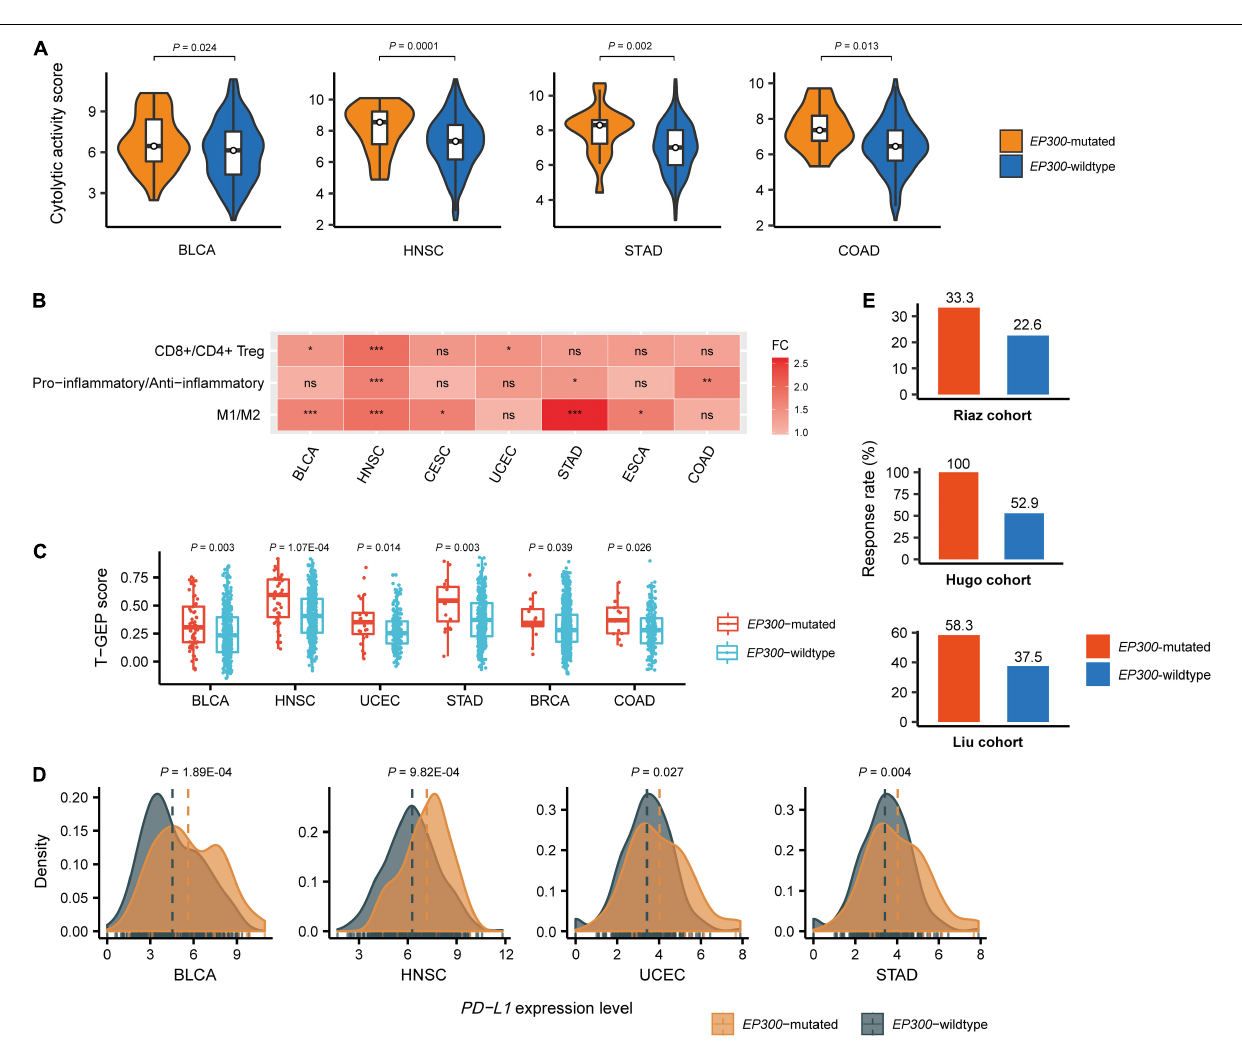
FIGURE 2 | Associations between E1A binding protein p300 ( EP300 ) mutations and antitumor immune signatures and immunotherapeutic response in cancer. Comparisons of immune cytolytic activity (CYT) scores (A) , the ratios of immune-stimulatory to immune-inhibitory signatures (CD8+/CD4+ regulatory T cells, pro-/anti-inflammatory cytokines, and M1/M2 macrophages) (B) , T cell-inflamed gene expression profile (T-GEP) scores (C) , programmed death-ligand 1 ( PD-L1 ) expression levels, and the response rates to immune checkpoint inhibitors (ICIs) (E) in EP300 -mutated and EP300 -wild-type cancers. The CYT score is the average expression level of two marker genes ( GZMA and PRF1 ) in the tumor (Narayanan et al., 2018). The ratio of immune-stimulatory to immune-inhibitory signatures is the log2-transformed geometric mean expression levels of the marker genes of immune-stimulatory signatures over those of immune-inhibitory signatures. The T-GEP score is the ssGSEA score of 18 T cell-inflamed genes (Ayers et al., 2017). The response rates to ICIs are for three melanoma cohorts receiving ICI treatments. The three cohorts included the Hugo et al. (2016), Riaz et al. (2017), and Liu and Schilling (2019) cohorts. The two-tailed Student’s t -test p -values are shown in (A,B,D) , and the one-tailed Mann–Whitney U test p -values are shown in C . * P < 0.05, ** P < 0.01, *** P < 0.001, ns not